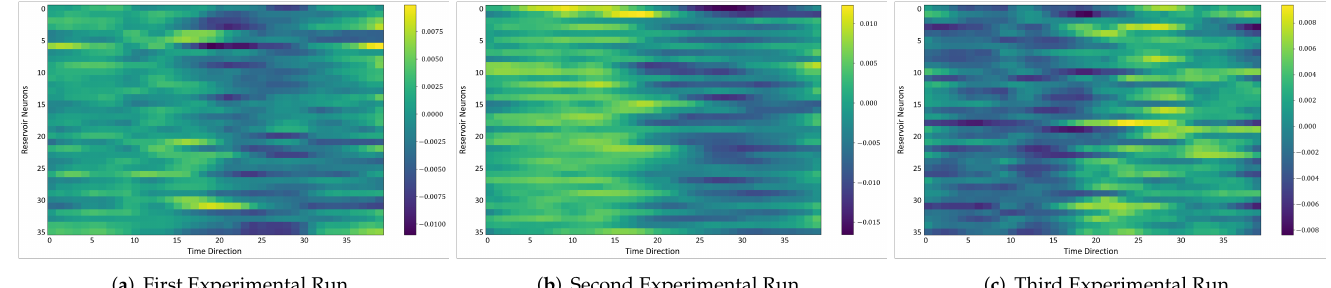
Figure 14. Visualization of ESRs of randomly initialized reservoir with 36 neurons for right arm trajectories of a person performing two-hand waving.